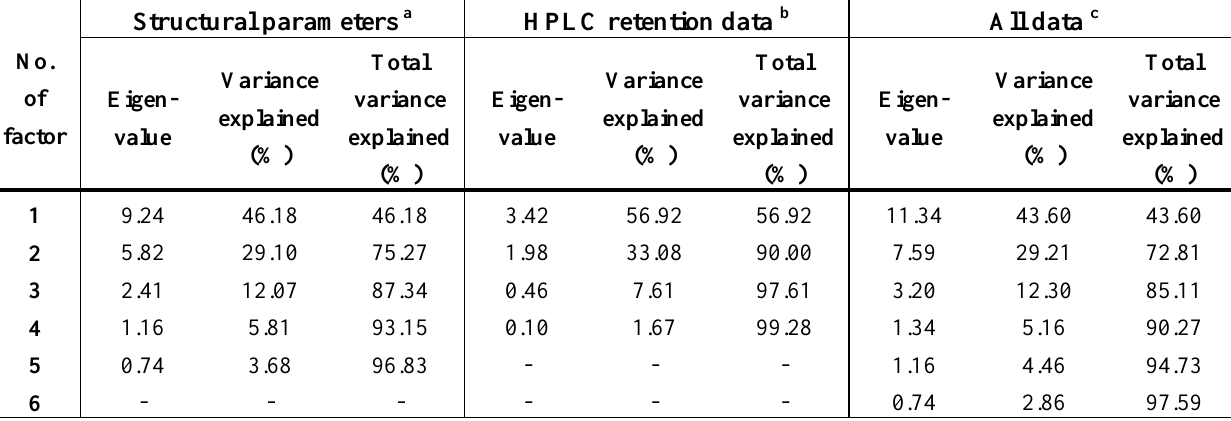
Table 3. Summary of the results of principal component analysis derived for the compounds studied.